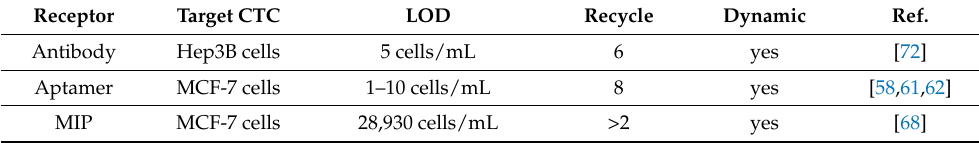
Table 1. Performance comparison of different recognition element-based electrochemical